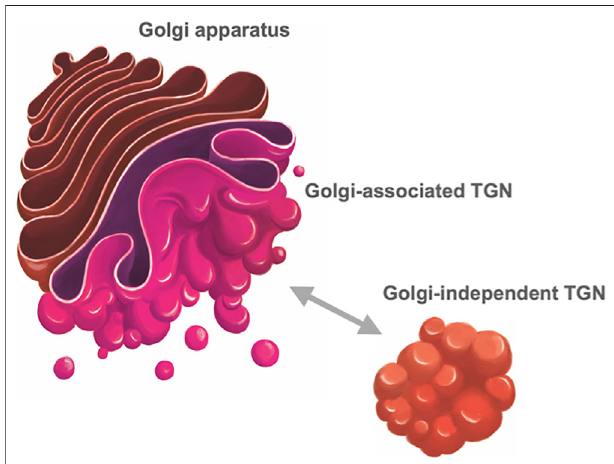
FIGURE3| Trans -Golginetworkofplantcells.Inplantcells,TGN( trans - Golgi network) takes two statuses, one being attached to the trans face of the Golgi (Golgi-associated TGN) and the other detached from the Golgi and free in the cytoplasm (Golgi-independent TGN) (Staehelin and Kang, 2008; Uemura et al., 2014). These two statuses are interchangeable; Golgi- independent TGN can dissociate from the Golgi and reassociate with it.